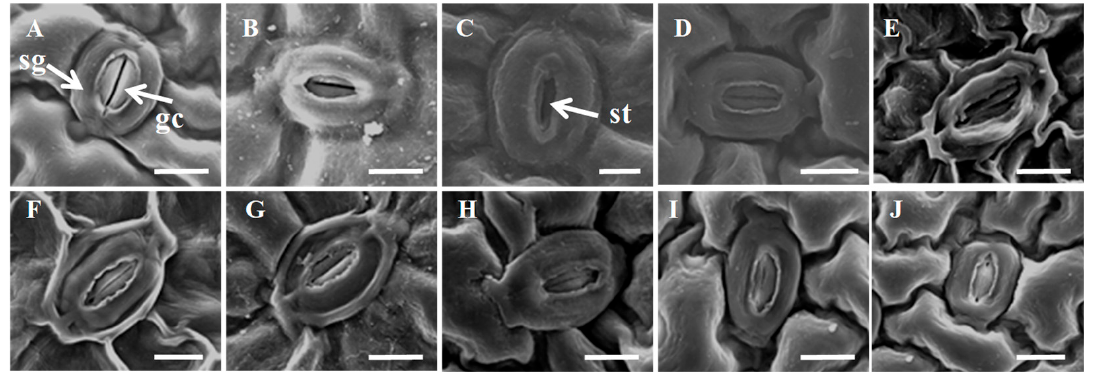
Figure 6. Stomata micrographs under scanning electron microscope in ten wild tree peonies, all abaxial. ( A ) P. qiui ; ( B ) P. decomposita ; ( C ) P. jishanensis ; ( D ) P. ostii ; ( E ) P. delavayi ; ( F ) P. lutea ; ( G ) P. potanini ; ( H ) P. rockii ; ( I ) P. ludlowii ; ( J ) P. cathayana . Abbreviations: sg: subsidiary cell; gc: guard cells; st: stomatal pore. (bar = 10 μ m).